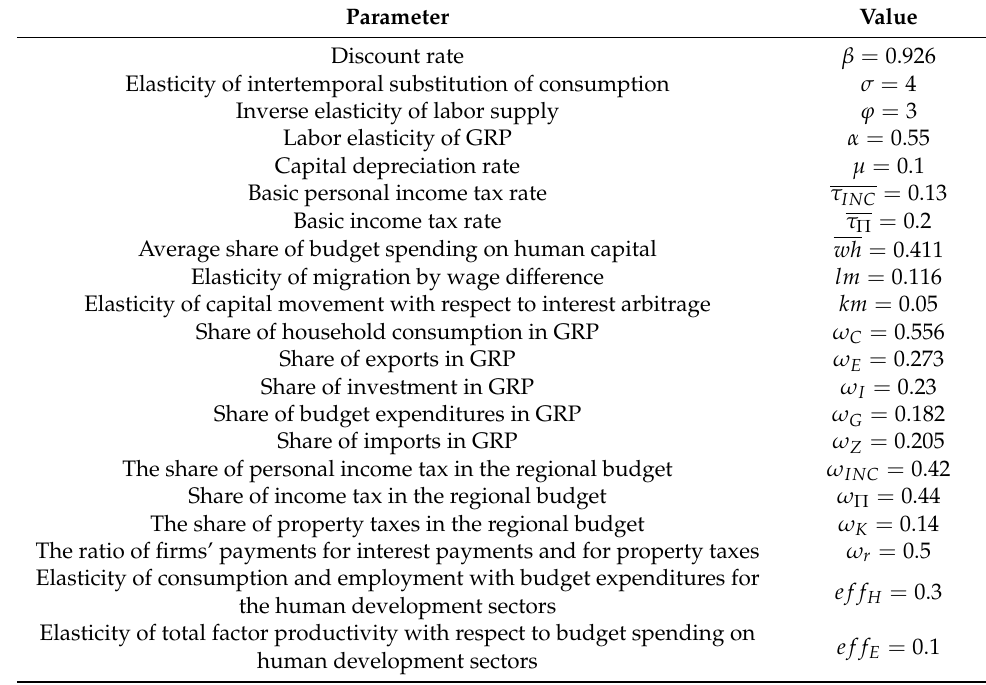
Table 1. Calibrated parameter values.